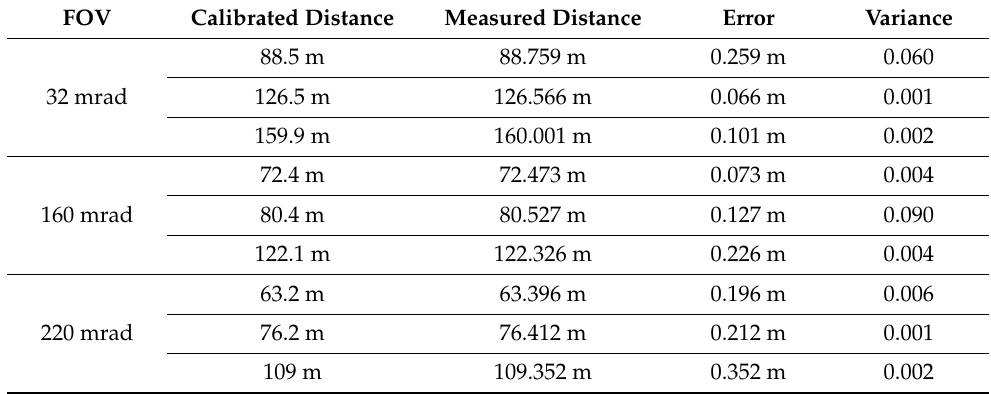
Table 2. Detection results at different distances and fields of